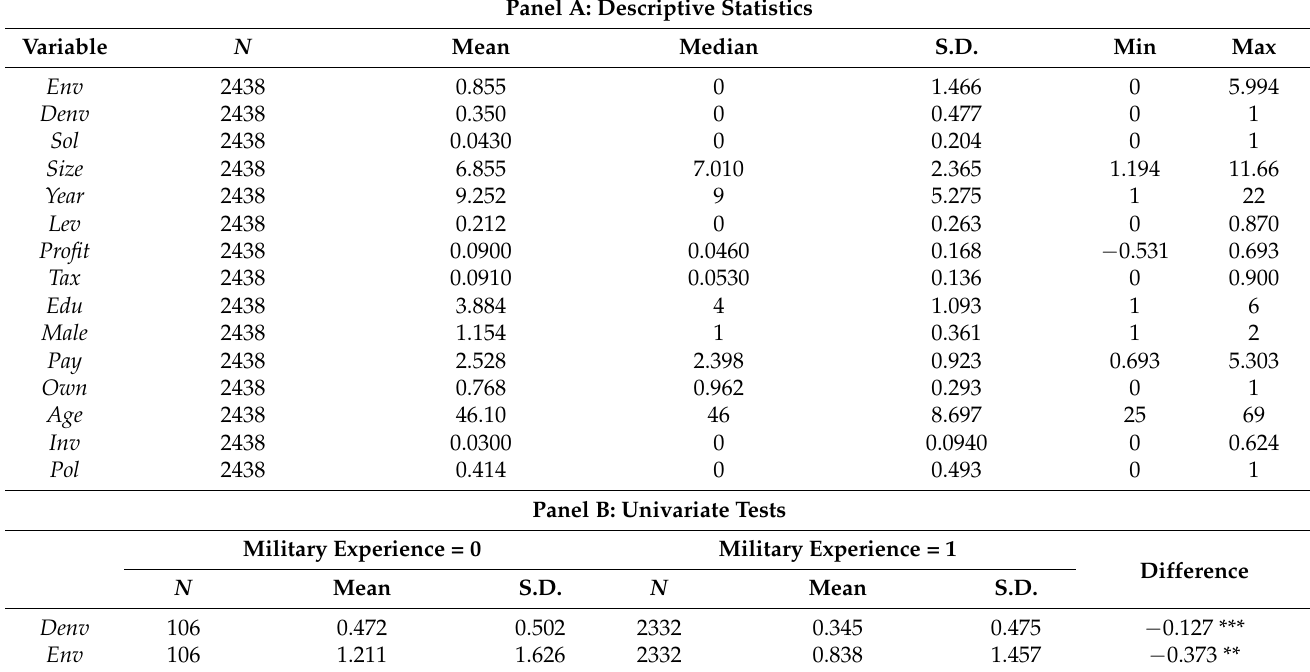
Table 1. Summary statistics.